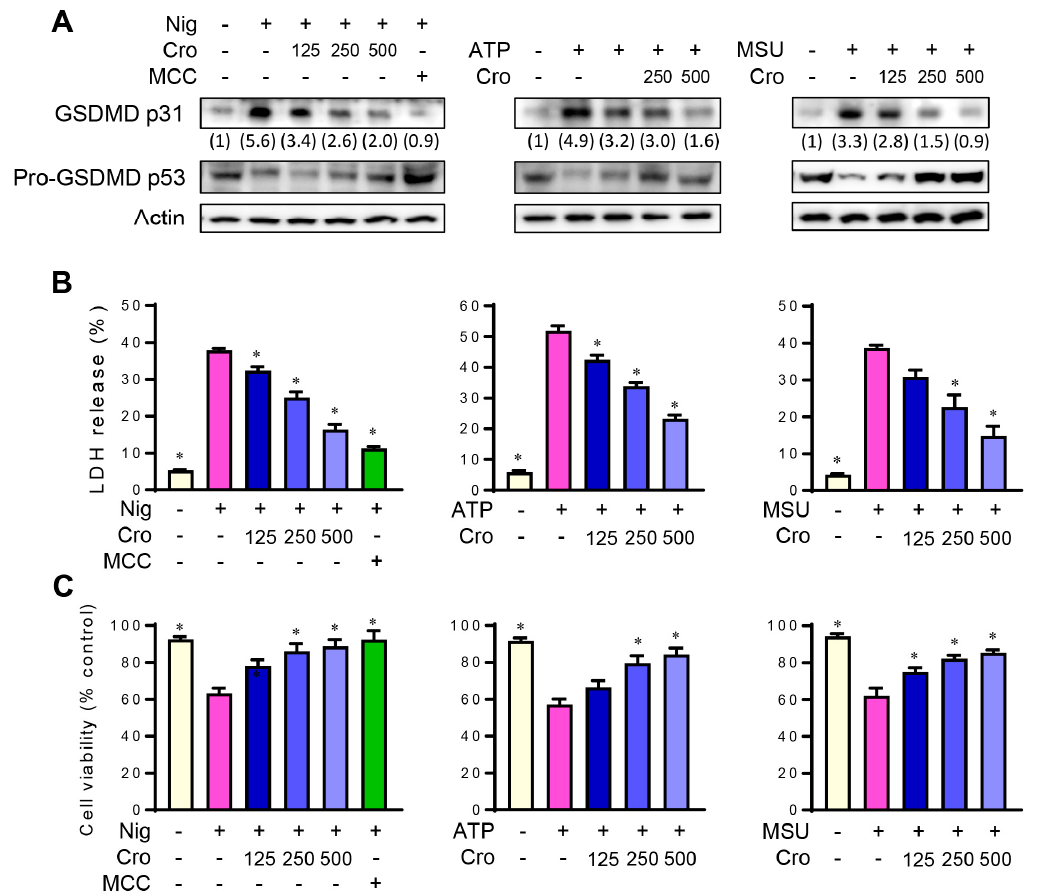
Figure 2. Inhibitory effects of Crocin on GSDMD cleavage, LDH release, and cell viability. LPS- primed J774A.1 cells were pretreated with various concentrations of Crocin (Cro, μ M) for 3 h or 0.1 μ M of MCC950 (M) for 1 h, and then incubated with Nigericin (Nig, 4 μ M) for 1 h, ATP (5 mM) for 1 h, or MSU (300 μ g/mL) for 6 h. ( A ) Cleaved GSDMD and pro-GSDMD were detected with cell lysates by Western blotting. Relative intensity of cleaved GSDMD was quantified using image analysis software, ImageJ (http://rsb.info.nih.gov/ij, accessed on 28 February 2023). ( B ) LDH release into the cell culture supernatant was measured. ( C ) Cell viability was assessed by the MTT assay. The data are expressed as the mean ± SEM and represent four experiments. * p < 0.05 vs. the group treated with Nigericin, ATP or MSU.